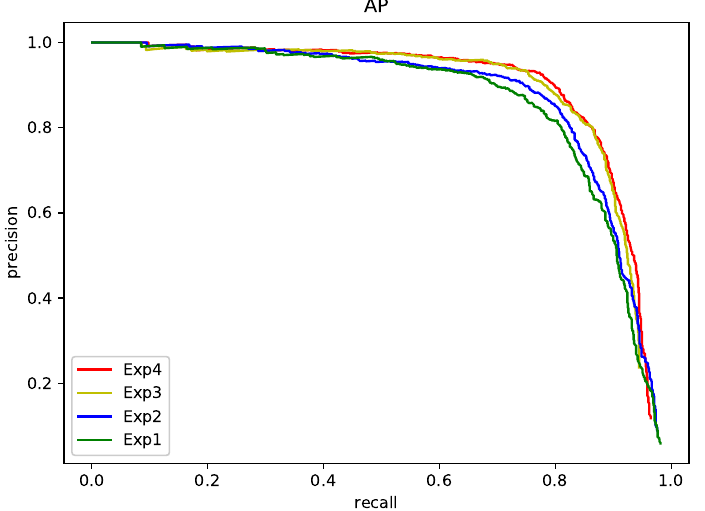
Figure 6. AP curve of ablation study, "Exp" represents the experimental sequence number in Table